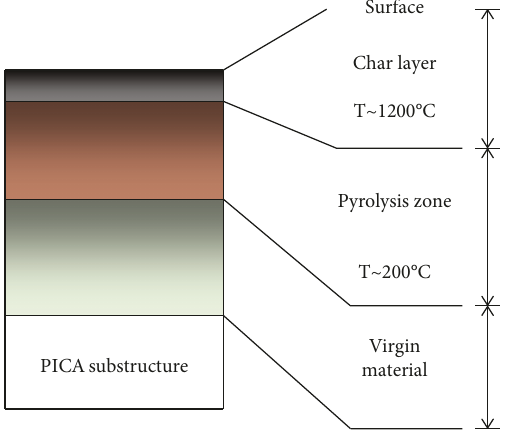
Figure 2: The layered structure of PICA material after surface ablation